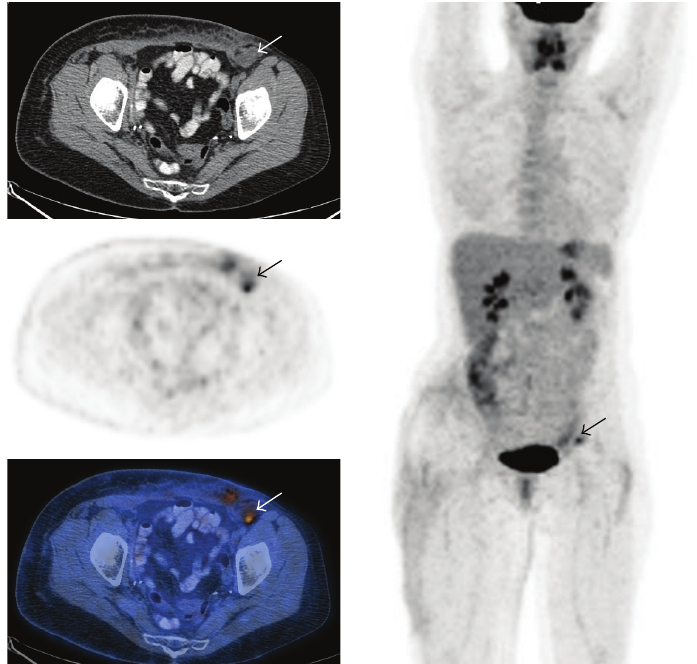
Figure 5: True positive that changed management; in 45-yea-old patient with a recently resected left lower abdominal wall angiosarcoma, PET/CT demonstrated uptake in the left inguinal region (arrow). This was subsequently biopsied and proven to be metastatic